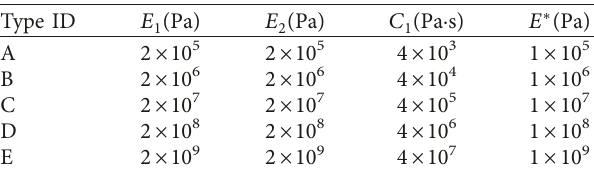
Figure 8: Pounding force time-history with five different material types: (a, f, k) Type A material; (b, g, l) Type B material; (c, h, m) Type C material; (d, i, n) Type D material; (e, j, o) Type E material. Table 2: Constitutive parameter of viscoelastic